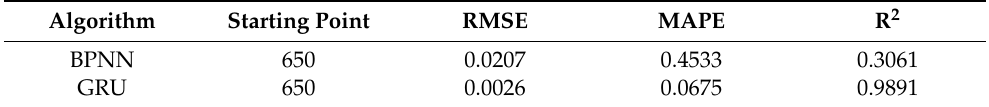
Table 2. Difference between BPNN and GRU.